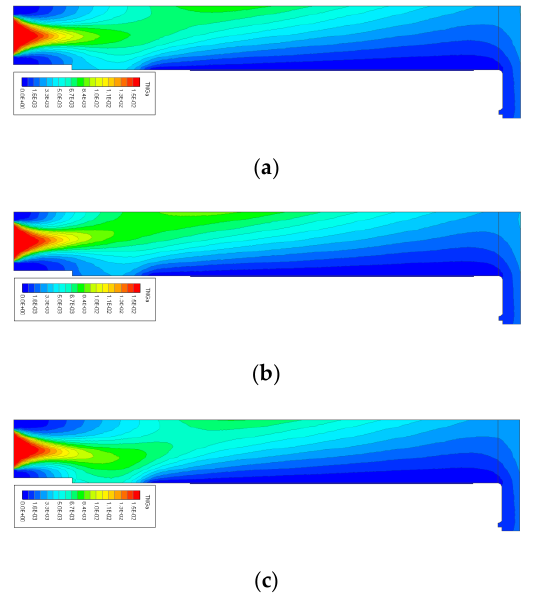
Figure 6. Two-dimensional distribution of TMGa in the reactor chamber for various top to bottom AsH 3 ratios: ( a ) 300:300; ( b ) 100:500; ( c ) 500:100.